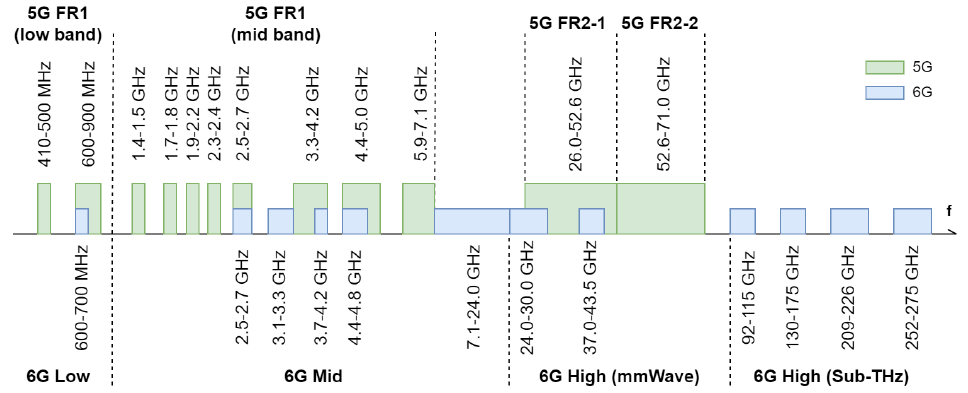
Figure 1. Spectrum allocation for 5G [143,144] and foreseen 6G bands